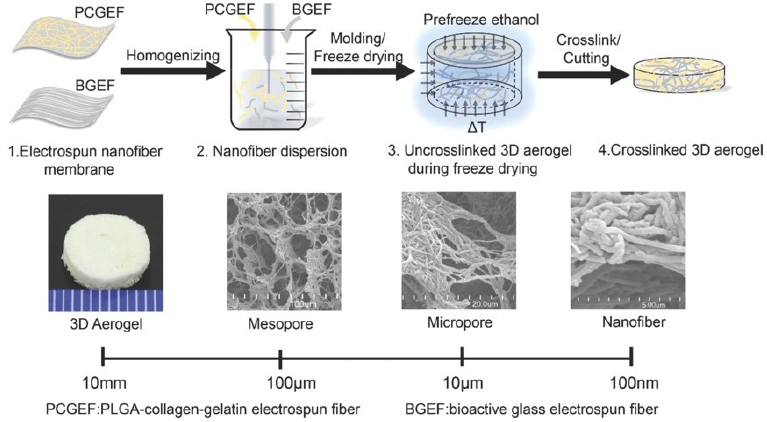
Figure 18. Schematic illustration of the fabrication of 3D hybrid aerogels from polymer